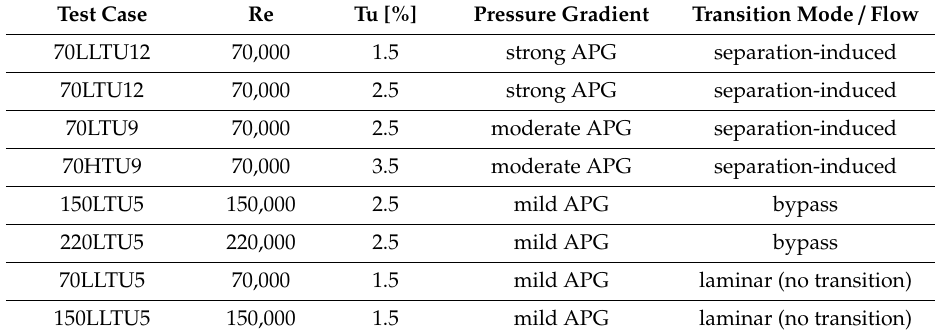
Figure 3. UNIGE (University of Genoa) flat plate. Computational domain (bounded by AB, BC, CD lines). The red AB and BC lines are inlets at which LDV data on mean and turbulent quantities are available. The PIV (Particle Image Velocimetry) domain is the shaded zone. Flow is from left to right. Table 2. Summary of UNIGE test cases. The Reynolds number is based on the plate length and the mean free-stream velocity at the leading edge of the plate. The free-stream turbulence intensity, Tu, is reported at the edge of the boundary layer at the inlet to the computational domain (60 mm downstream of the leading edge of the plate). The numbers 70, 150 and 220 refer to the Reynolds numbers (70k, 150k and 220k). The turbulence levels are coded by LLTU (lowest), LTU (low), HTU (high), HHTU (highest). The adverse pressure gradients are coded by the opening angle of the diverging section of the wind tunnel (0 ◦ , 5 ◦ , 9 ◦ and 12 ◦ ). The acronym APG stands for adverse pressure gradient.